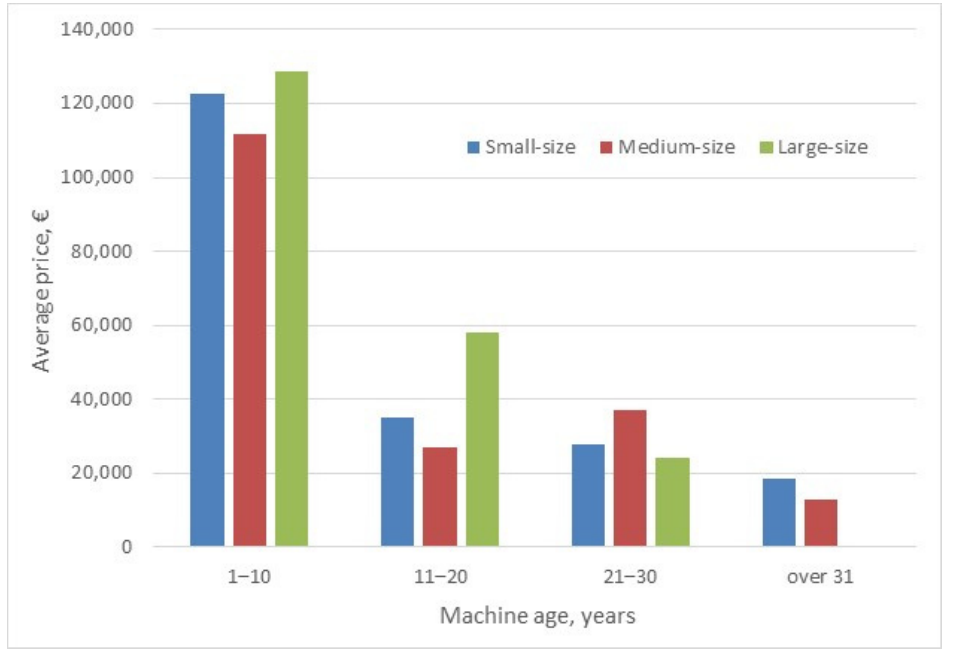
Figure 2. Average prices (EUR) of skidders by machine age and size class. age (years) and total machine working hours (Figures 3 and 4). The regressions show that resale price of skidders is more dependent on the age of the skidders than their total use.